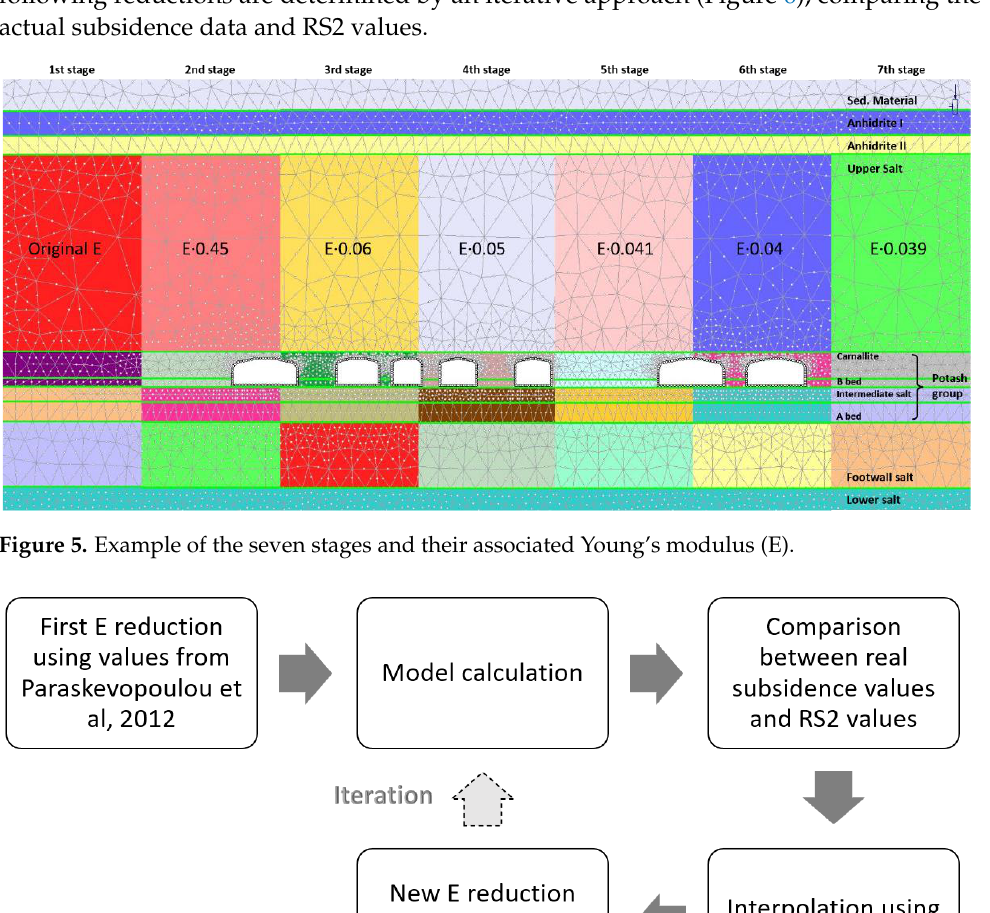
Figure 5. Example of the seven stages and their associated Young’s modulus (E).